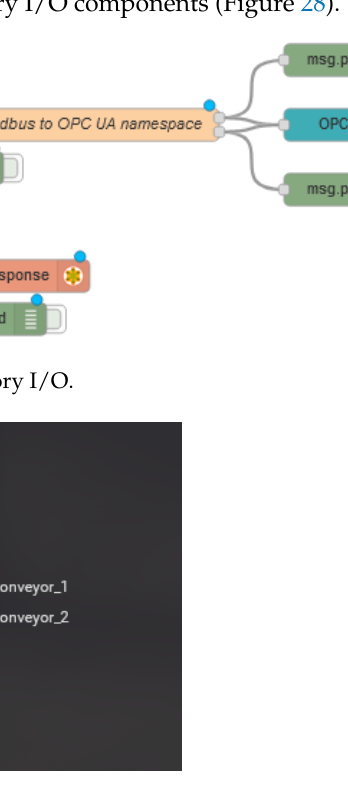
Figure 28. Factory